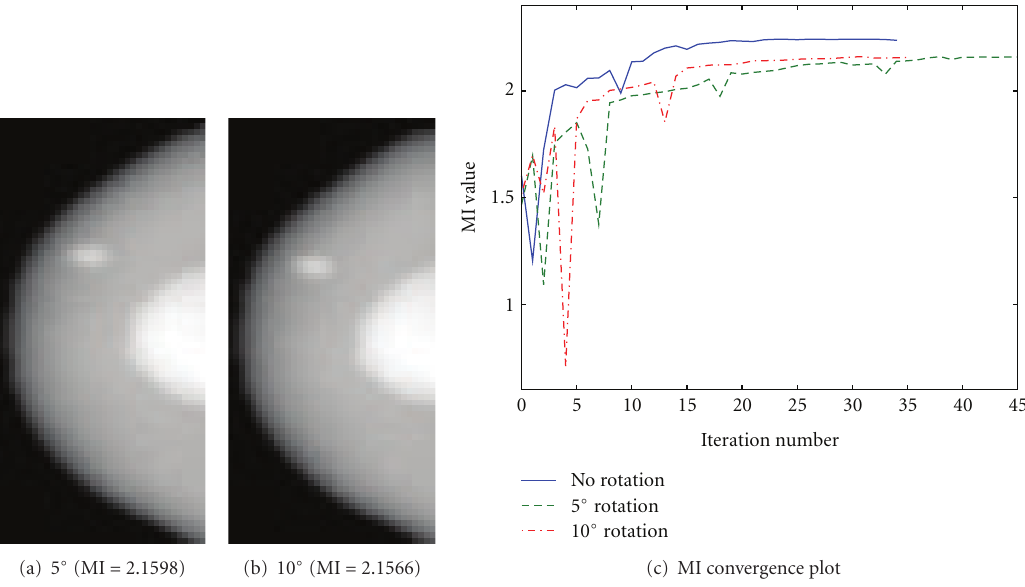
Figure 9: Results of registering simulated images following small misrotations of MR volume. Final images and the trend of MI values over time are